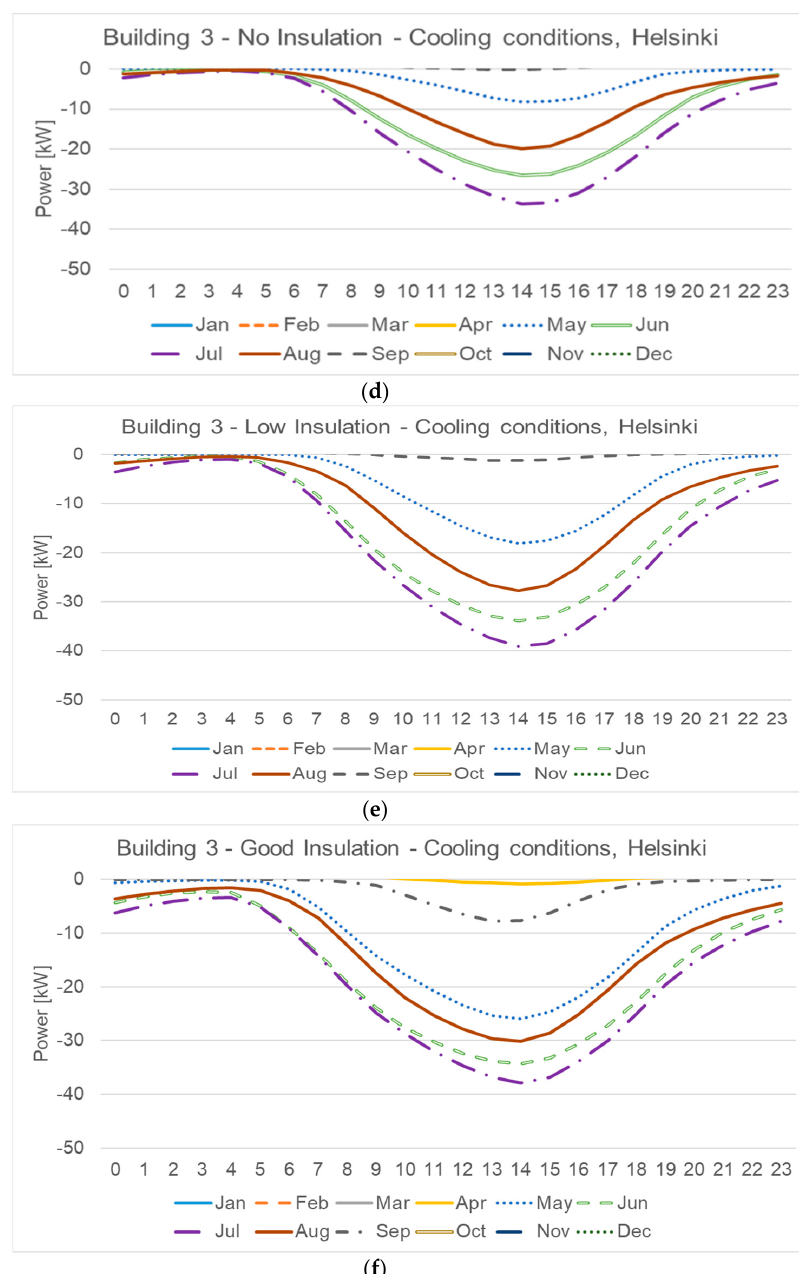
Figure 5. Hourly sensible load of the average monthly day for Building 3, Helsinki (Dfb) climate conditions: ( a ) Heating conditions and no insulation, ( b ) heating conditions and low insulation, ( c ) heating conditions and good insulation, ( d ) cooling condition and no insulation, ( e ) cooling condition and low insulation, ( f ) cooling condition and good insulation.